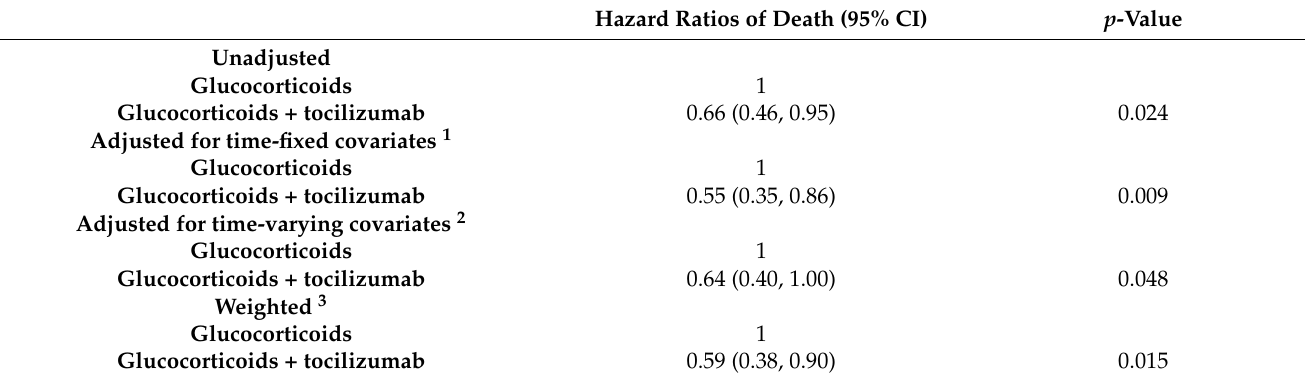
Table 4. Unadjusted and adjusted HR of death from fitting Cox regression models—all participants.